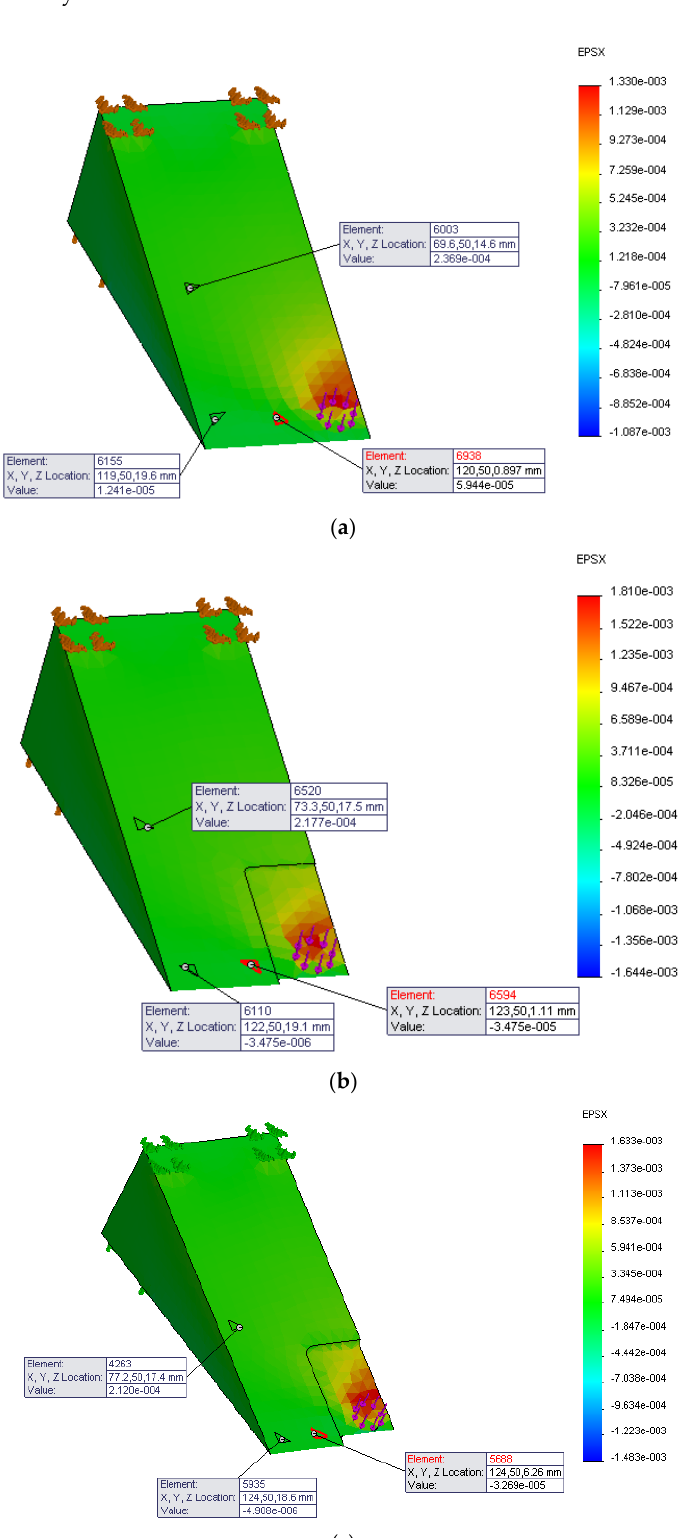
Figure 14. The equivalent strain calculated at three points from tests ( a ) without cut, ( b ) with 1 mm cut, and ( c ) with 2 mm